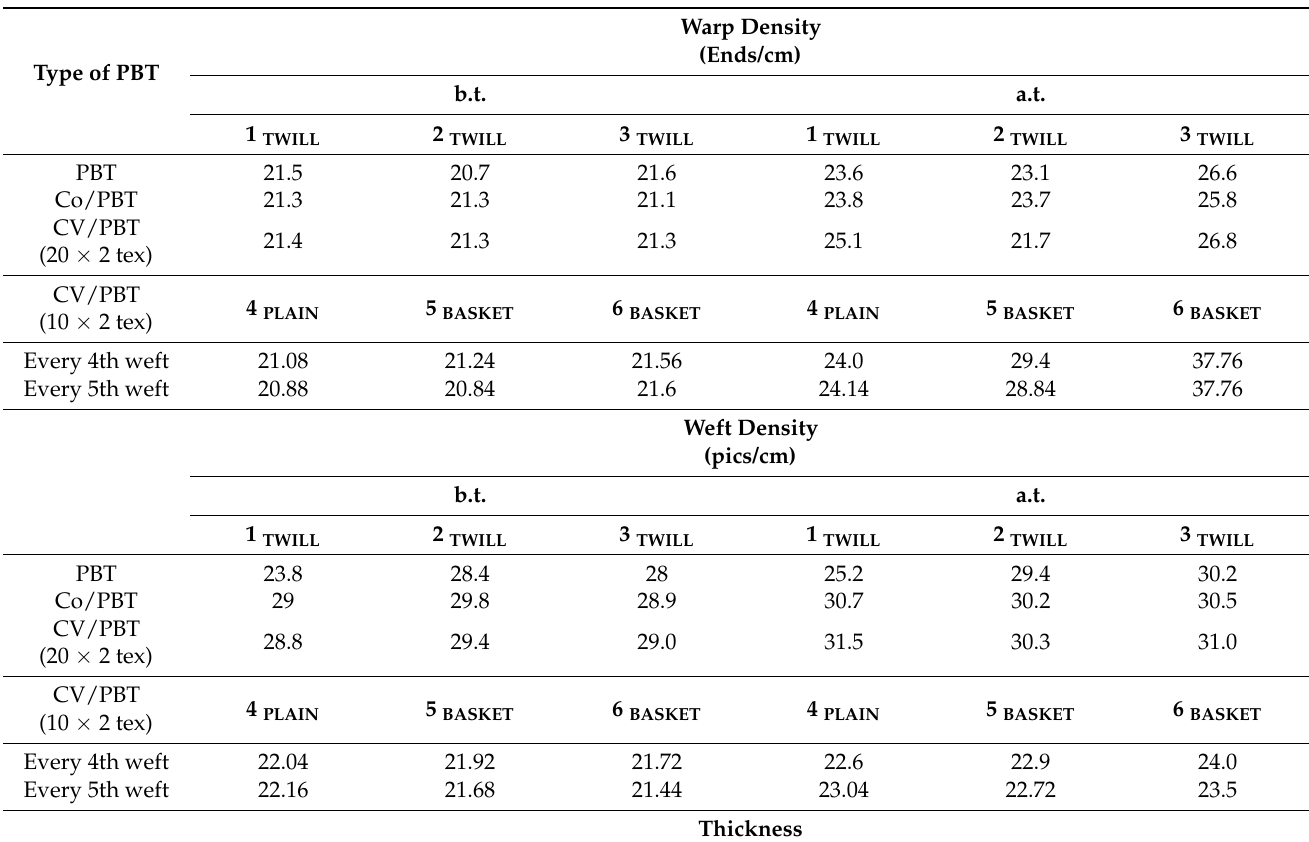
Table A7. Physical properties of samples before (b.t.) and after (a.t.)